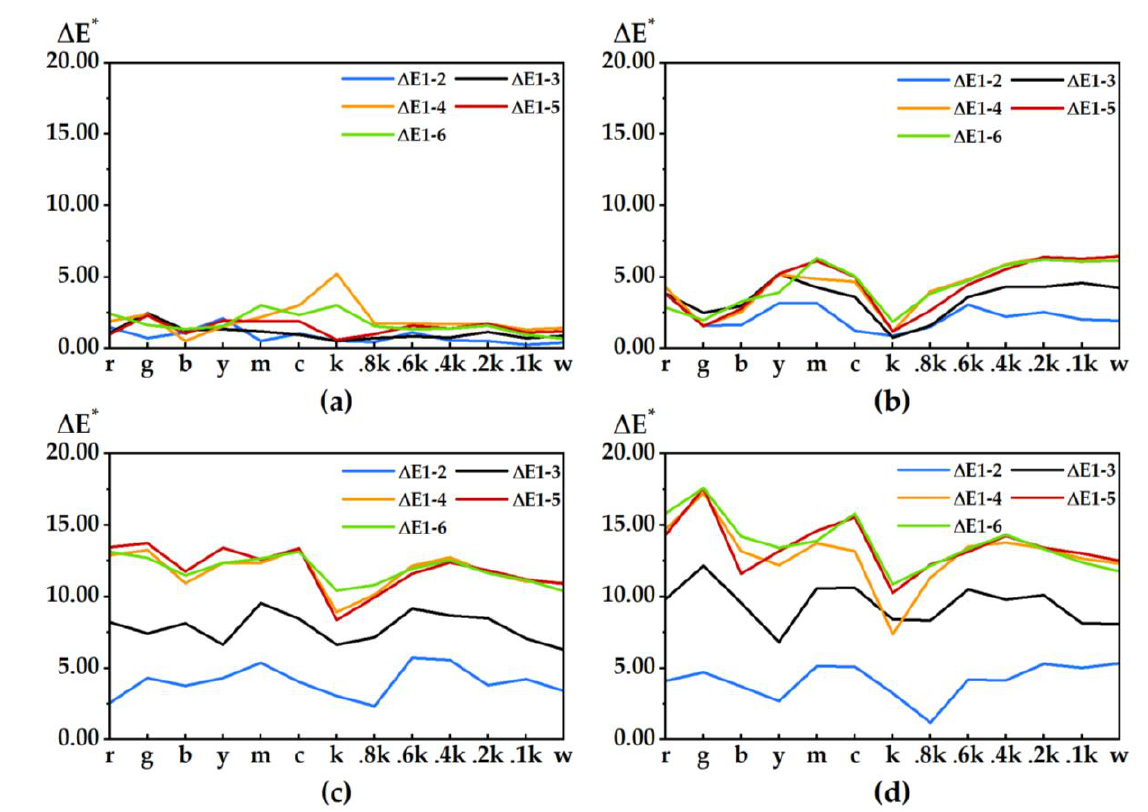
Figure 4. Three-dimensional test plate surface chromaticity: ( a ) test plate I; ( b ) test plate II; ( c ) test plate III; ( d ) test plate IV. plate III; ( d ) test plate